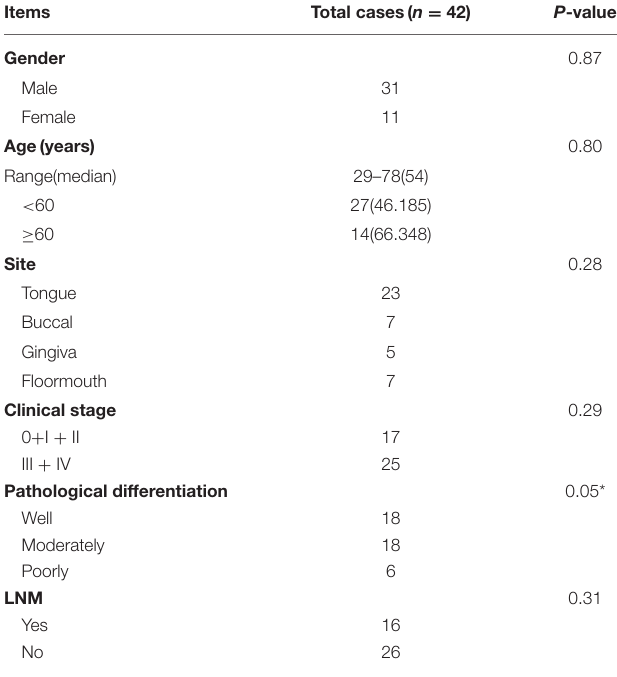
TABLE 2 | Correlation between hsa_circ_006740 expression and clinicopathological characteristics in 42 oral squamous cell carcinoma patients. Items Total cases( n =